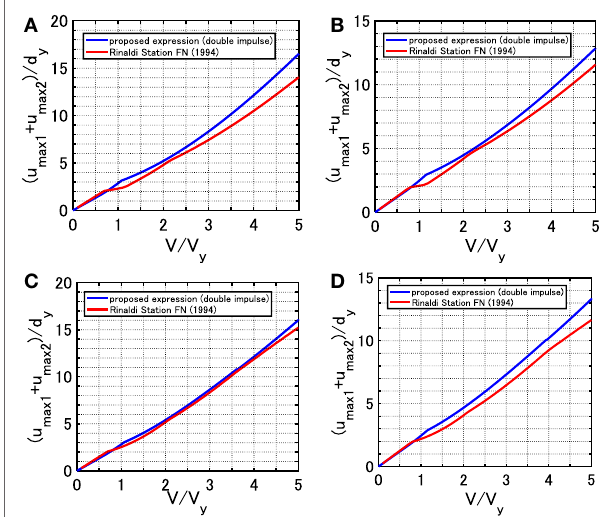
FIGURE 14 | Comparison of maximum amplitude of deformation of models with α = 0.1, 0.3, h = 0.05, 0.1 under critical double impulse (using quadratic function approximation) and recorded ground motion (Rinaldi Sta. FN comp.), (A) α = 0.1, h = 0.05, (B) α = 0.1, h = 0.1, (C) α = 0.3, h = 0.05, and (D) α = 0.3, h =